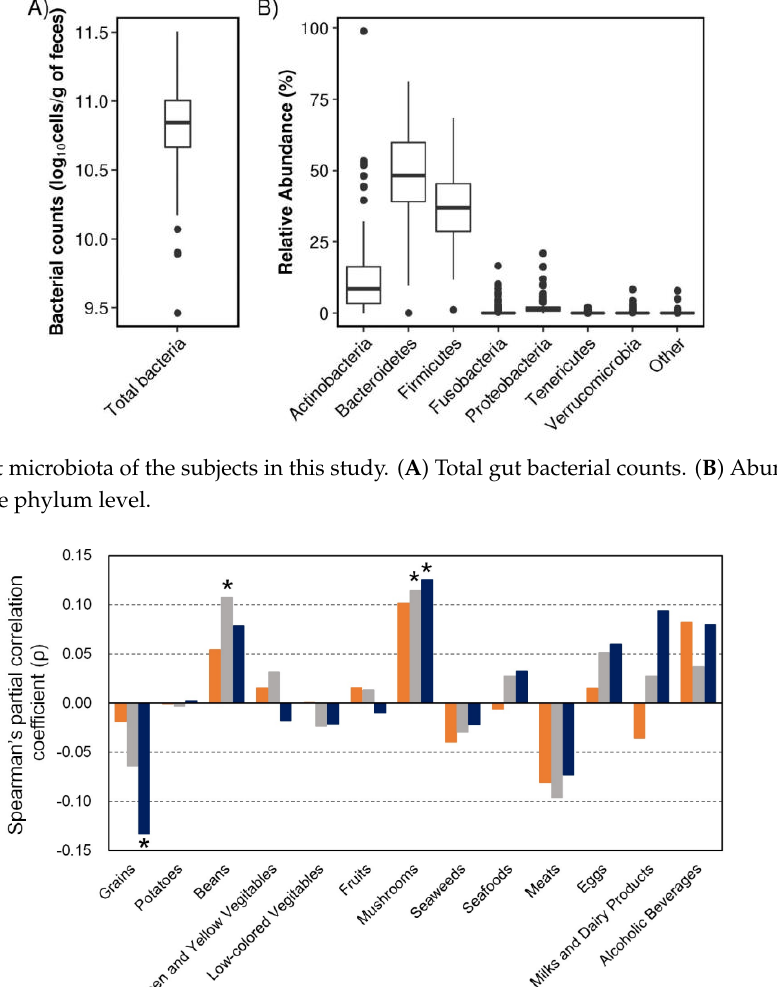
Figure 2. Association between α -diversity of gut microbiota and intake of each food group. Spearman’s partial correlation coe ffi cient adjusted for sex, age, BMI, smoking habit, and total energy intake was calculated for α -diversity indexes (Shannon index, observed ASVs, and Faith’s PD) and intake of each food group. * p < 0.05.